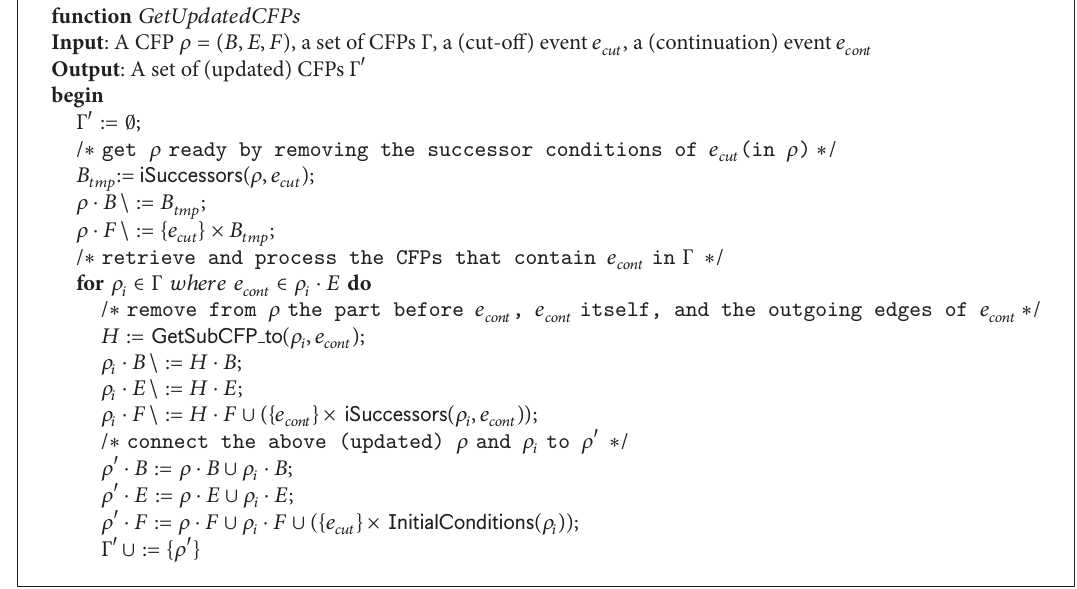
Algorithm 4: Updating a CFP with a cut-off event that links to a continuation event outside the CFP.